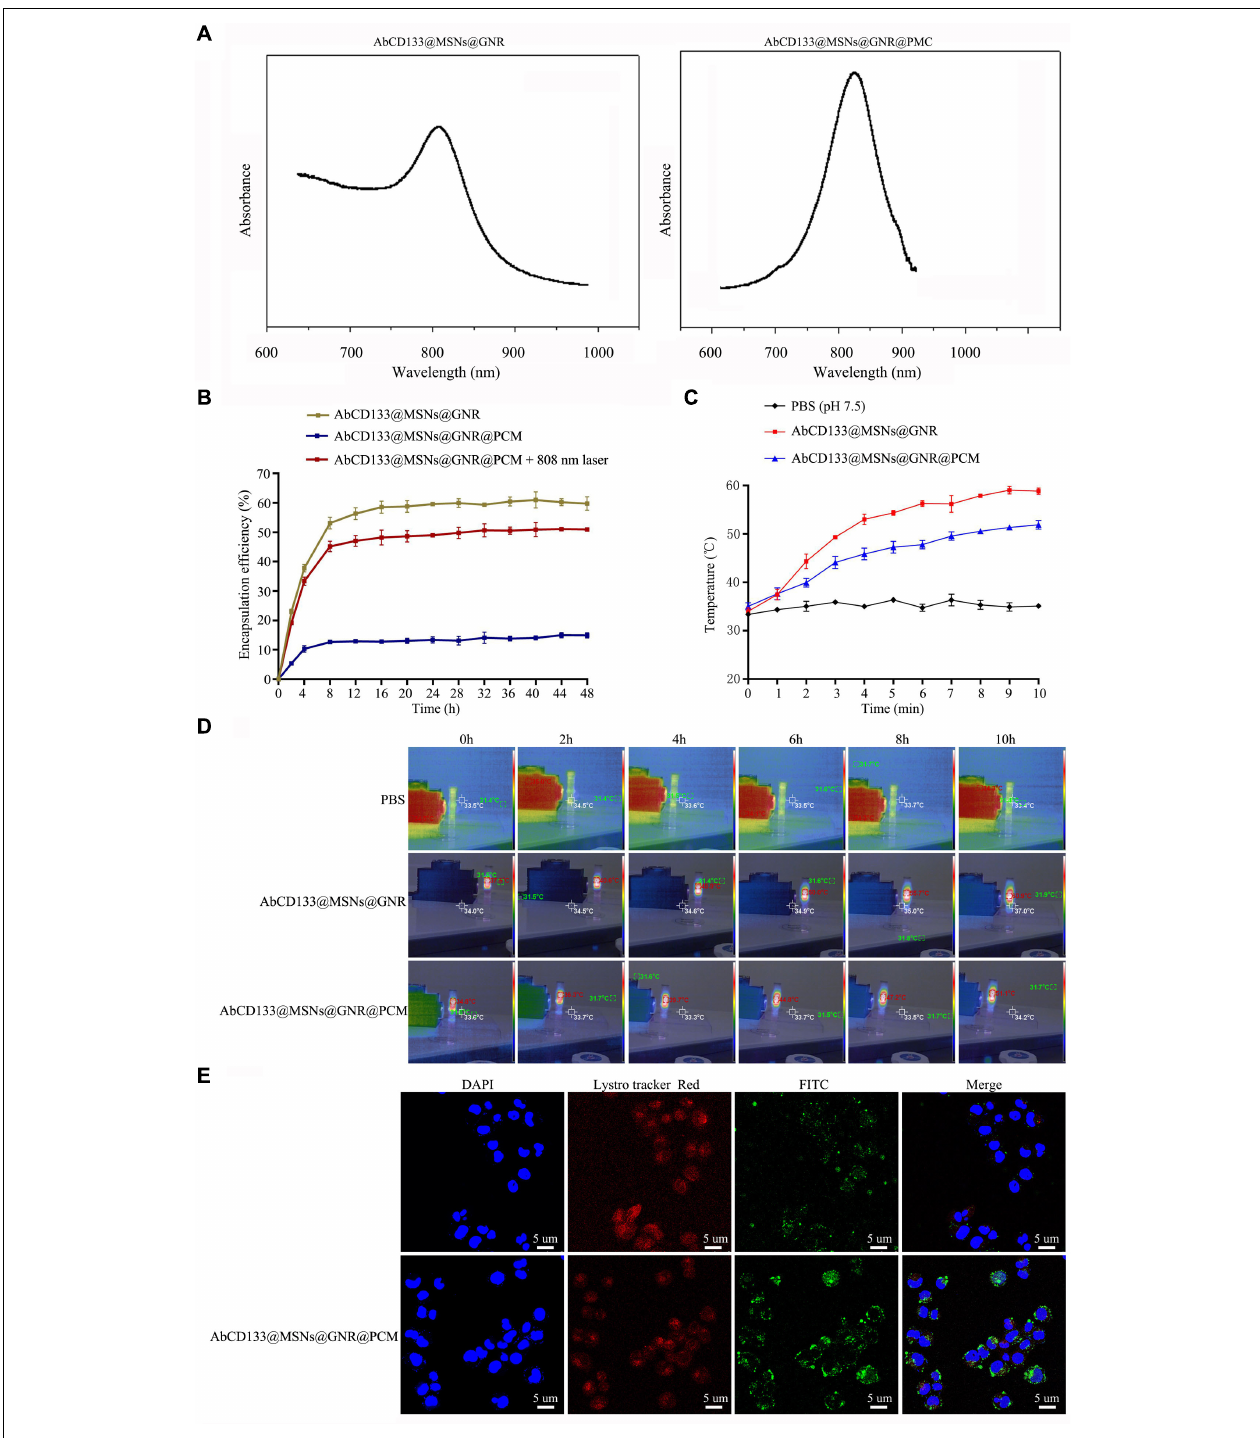
FIGURE 5 | MicroRNA loading capacity, release performance, photothermal properties, and cell internalization of AbCD133@GNR@MSNs. (A) UV absorption spectrum detection of AbCD133@GNR@MSNs and AbCD133@GNR@MSNs@PCM. (B) Cell Counting Kit-8 (CCK-8) assay was used to test the biocompatibility of AbCD133@GNR@MSNs with or without 808-nm laser irradiation. (C,D) The photothermal properties of AbCD133@GNR@MSNs and AbCD133@GNR@MSNs@PCM determined under 808-nm laser irradiation. (E) Laser confocal microscopy was used to detect prostate cancer stem cell (PCSC) internalization of GNR@MSNs and